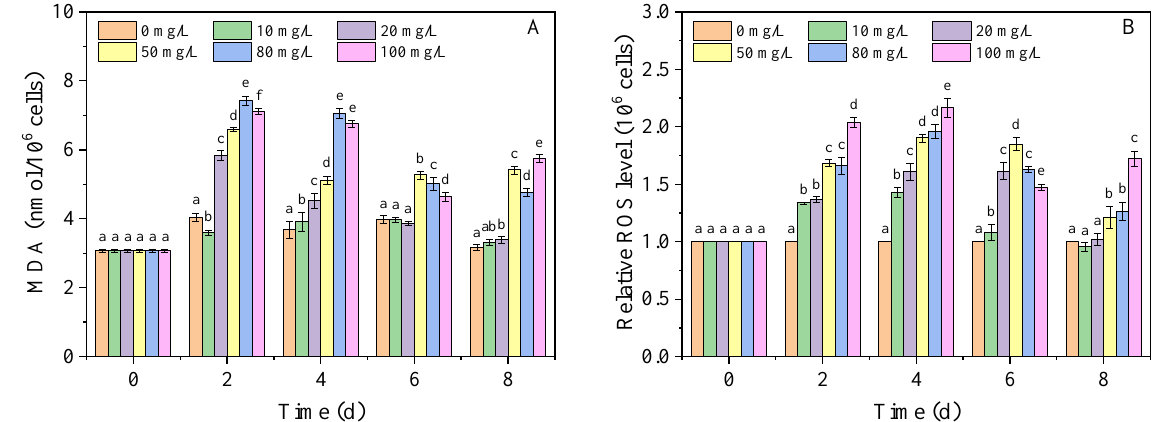
Figure 2. The MDA content ( A ) and relative ROS level ( B ) of A. carterae in different concentrations of nano-PS groups. Different letters represent significant differences ( p < 0.05).